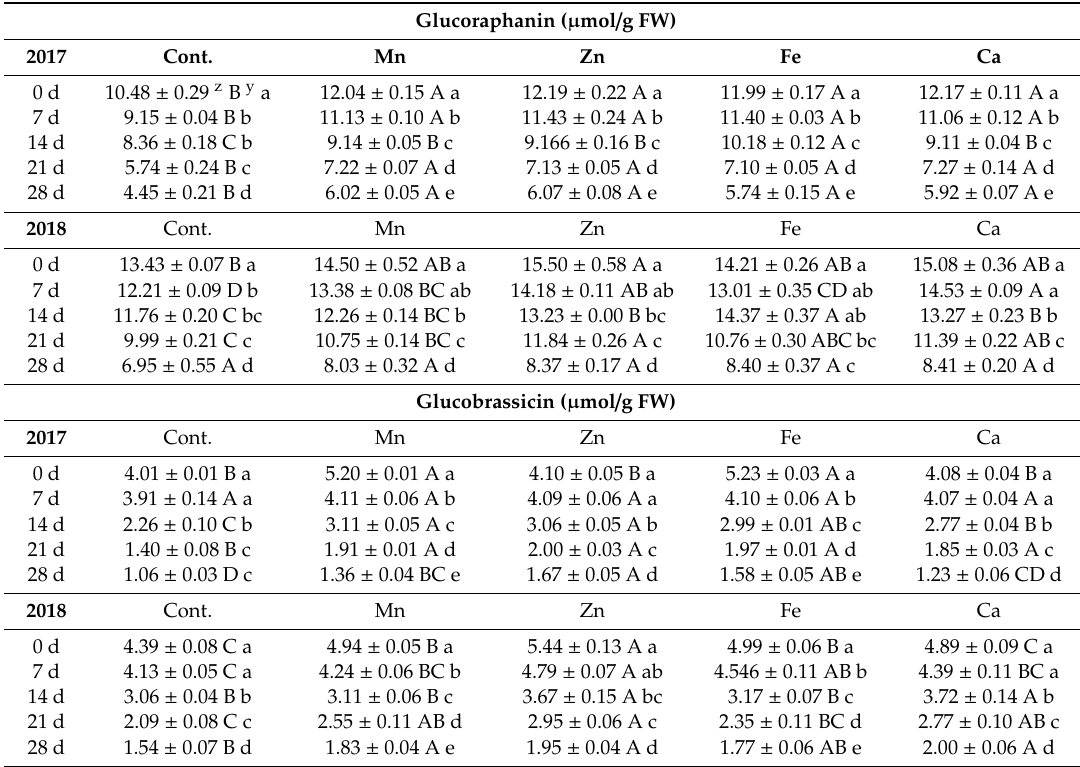
Table 4. E ff ect of foliar application of Ca, Mn, Zn, Fe elements plus water as the control on glucoraphanin and glucobrassicin of broccoli florets stored for 28 days at 4 ◦